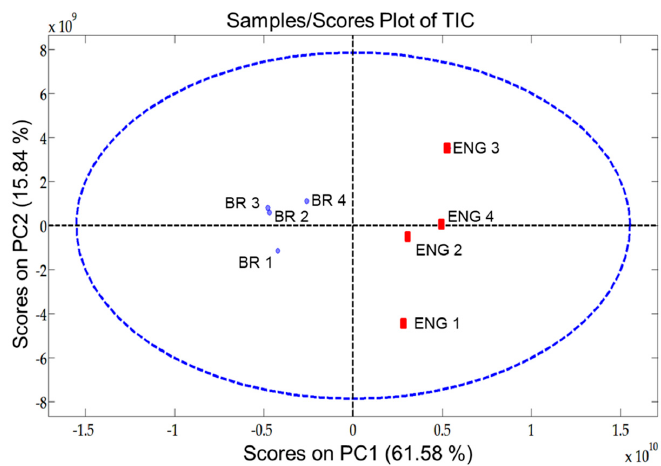
Figure 4. Scores plot of pixel-based two component Multiway principal components analysis